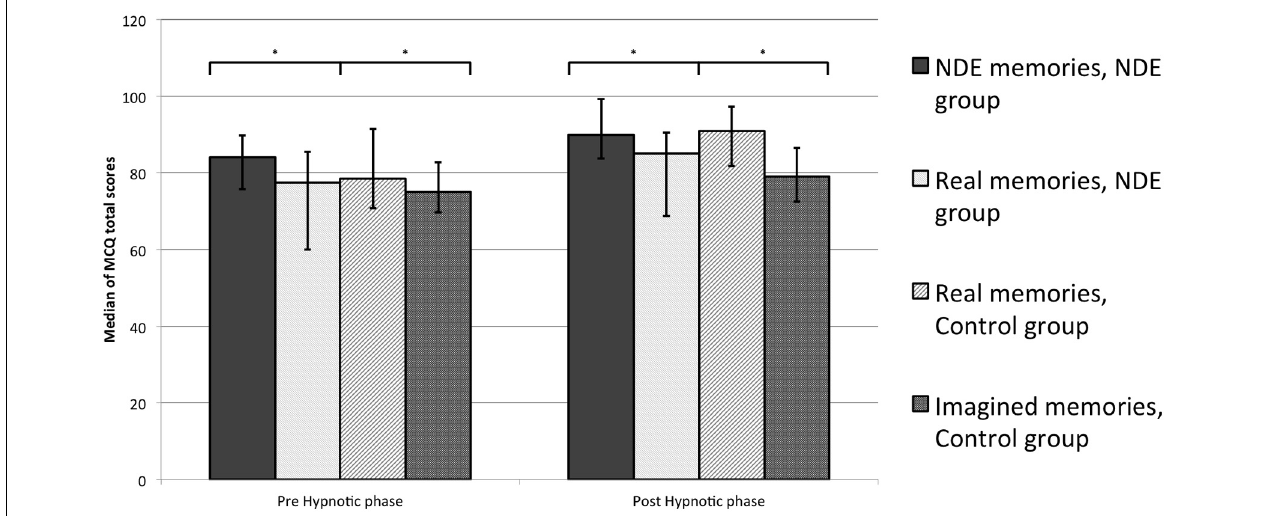
FIGURE 1 | Memory Characteristics Questionnaire (MCQ) total scores for each assessed memory. Median and interquartile ranges are presented ( ∗ p < 0 .